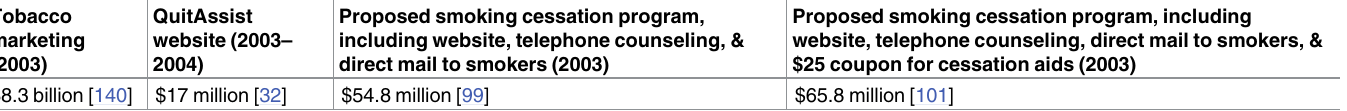
Table 4. Philip Morris USA expenditures on tobacco marketingand adult smoking cessation programs,